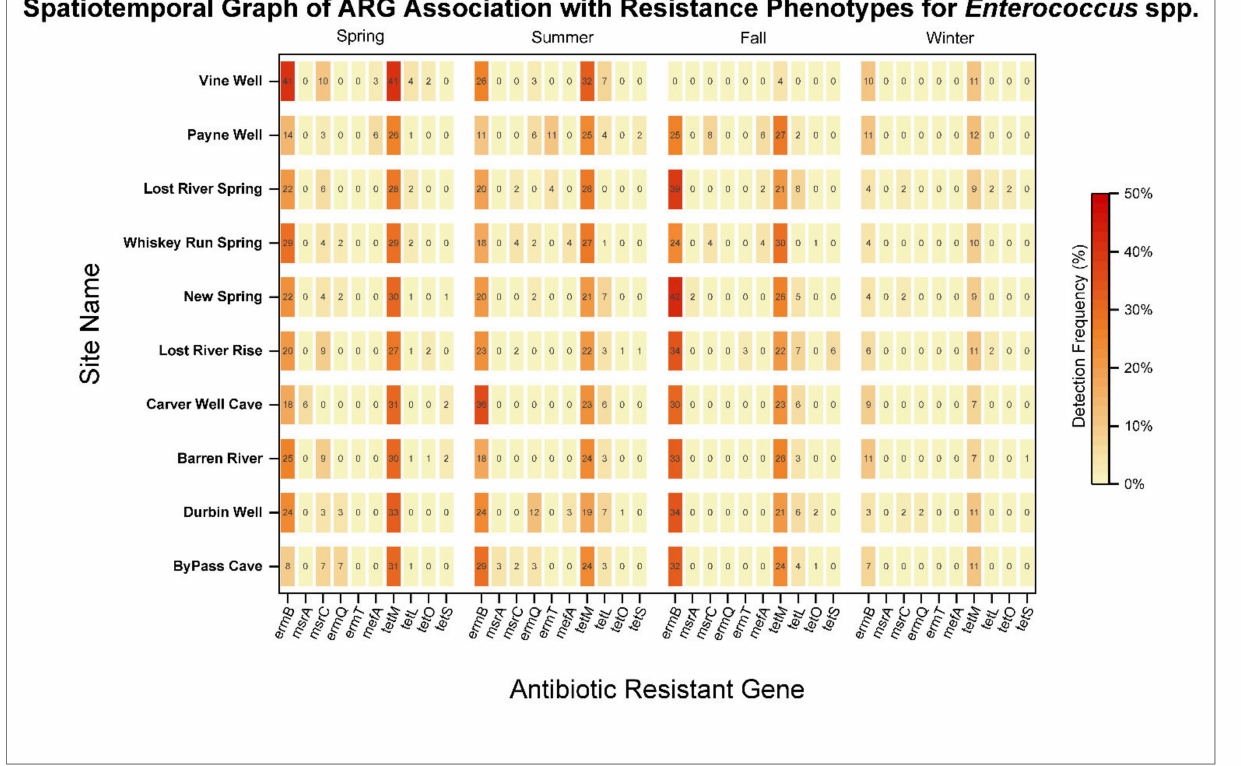
Figure 11. Spatiotemporal trends of ARGs associated with resistance phenotypes for Enterococcus spp.